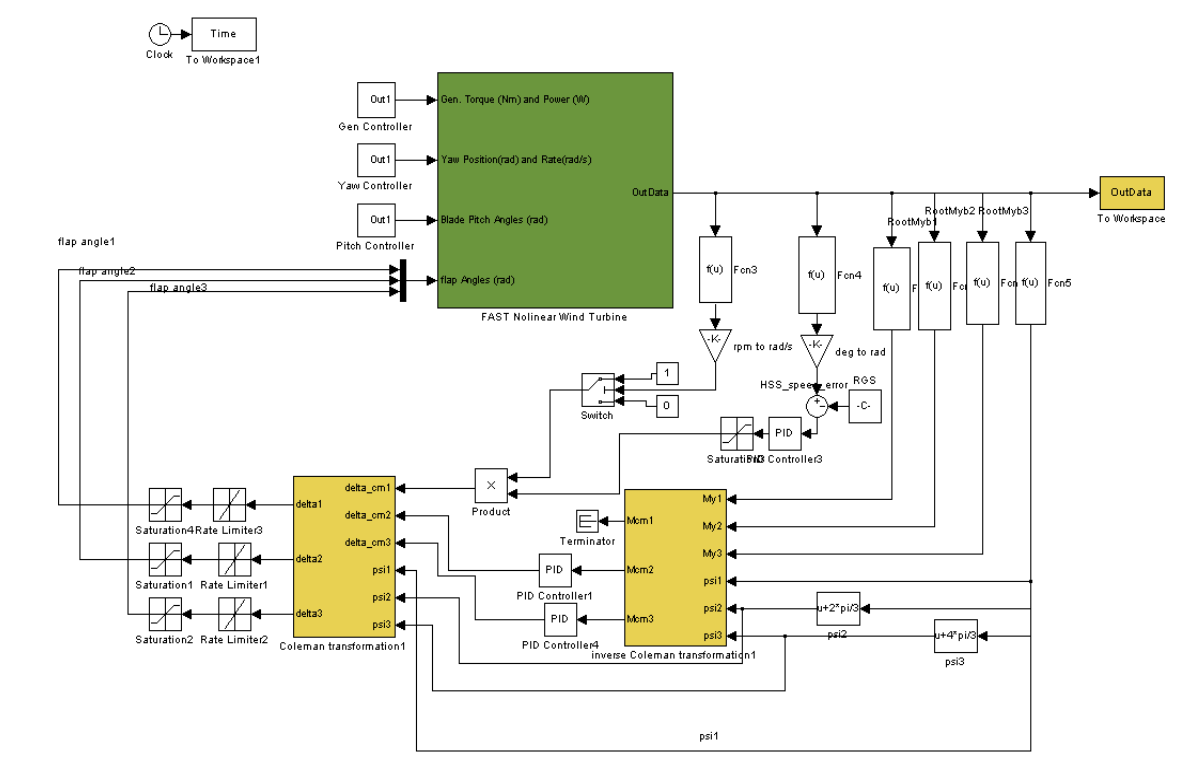
Figure 5. Feedback control scheme of DTEF implemented in FAST/Aerodyn and Matlab/Simulink codes.